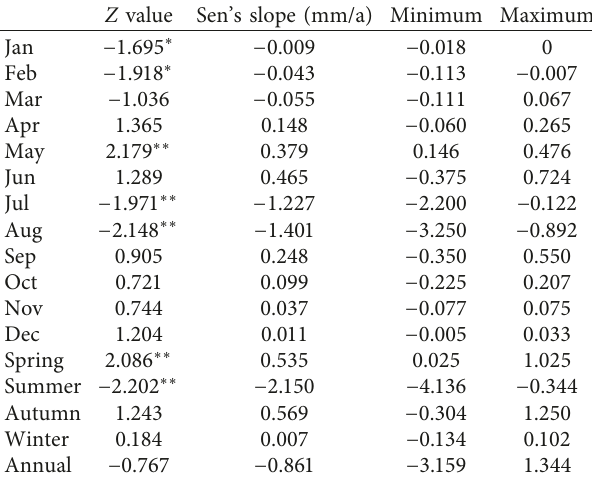
Table 3: Trend test results of the monthly, seasonal, and annual precipitation during 1960–2012 tested by the M-K method and Sen’s slope method. The uncertainty range covered from 5% to 95% between the minimum and maximum values of Sen’s slope.